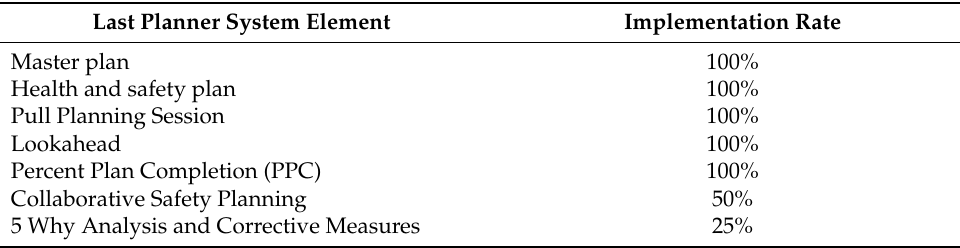
Table 4. Initial Level of implementation of the LPS of the Project.